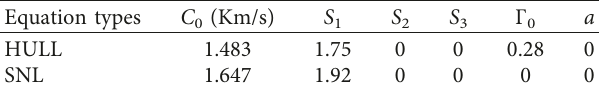
Table 5: Parameters of two shock state